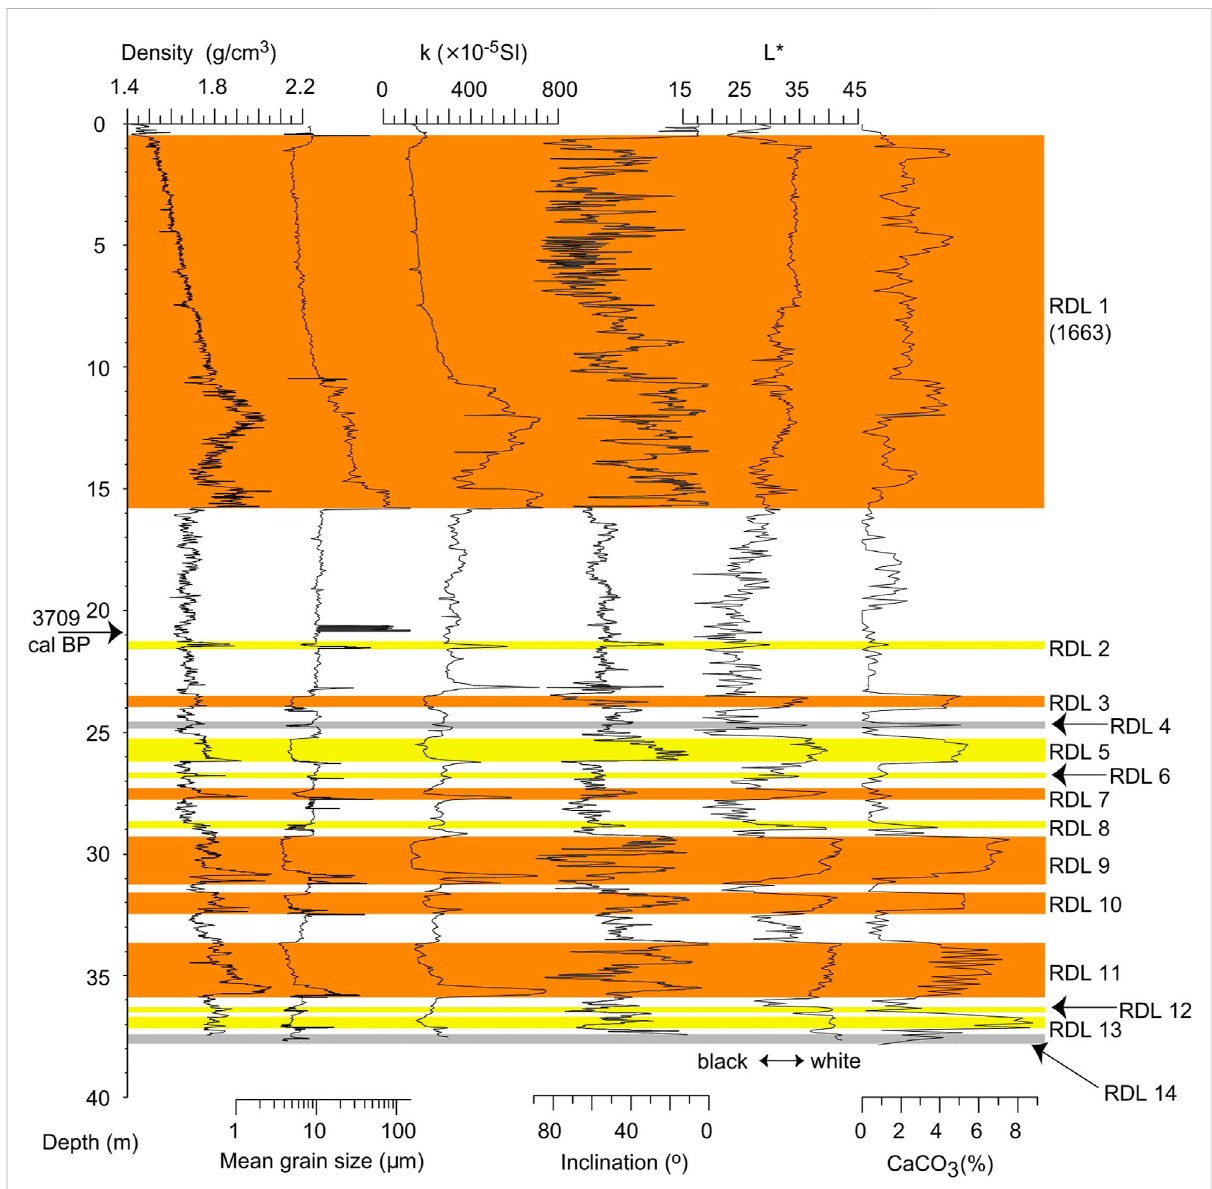
FIGURE 2 Sedimentological and physical properties of core MD99-2222 (St-Onge et al.,